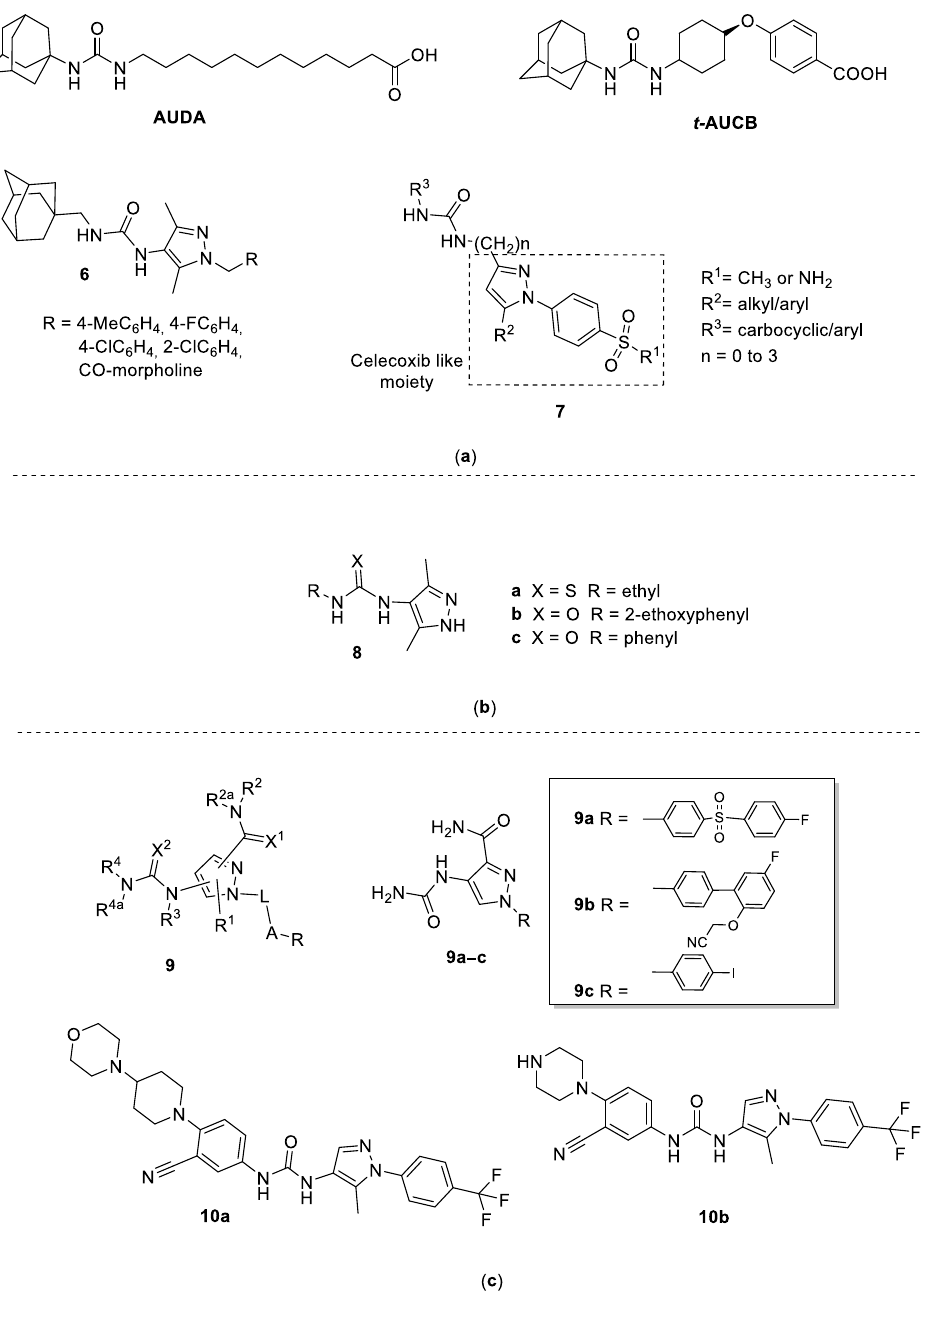
Figure 2. 4-Pyrazolyl-ureas reported as: ( a ) sEH inhibitors; ( b ) anticonvulsant; ( c ) anti-inflammatory agents.